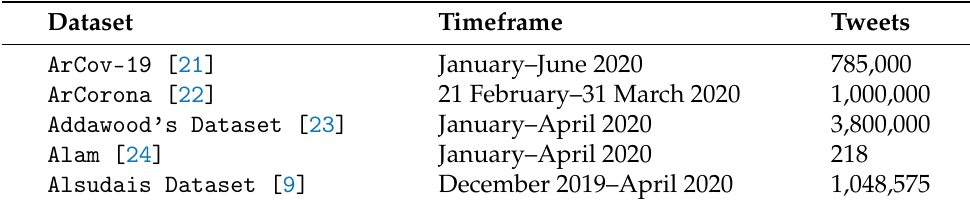
Table 1. Public Annotated COVID-19 Datasets in Arabic